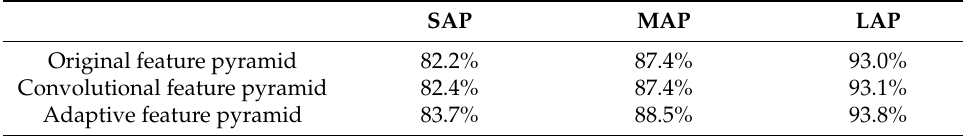
Table 1. Evaluation results of different feature pyramid structures.